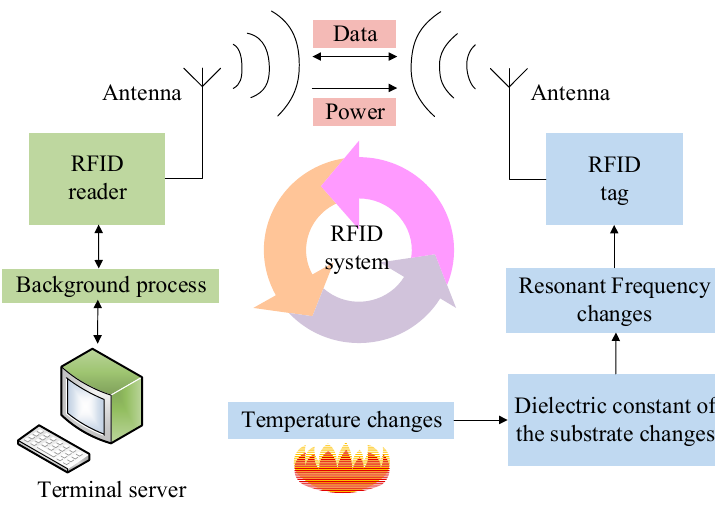
Figure 1. The flow chart of the wireless RFID (radio frequency identification) sensor operation.